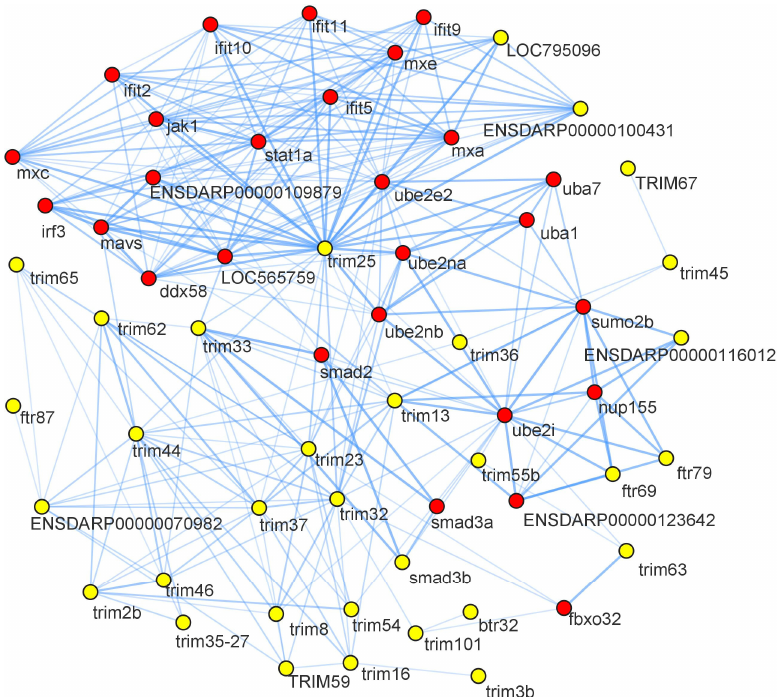
Figure 8. Protein-protein interaction network predictions are shown, yellow nodes indicate the CcTrim proteins and red nodes are their interacting partners. The name of node is shown as the proteins name to the string database identifier. The disconnected nodes are not present in the given figure.